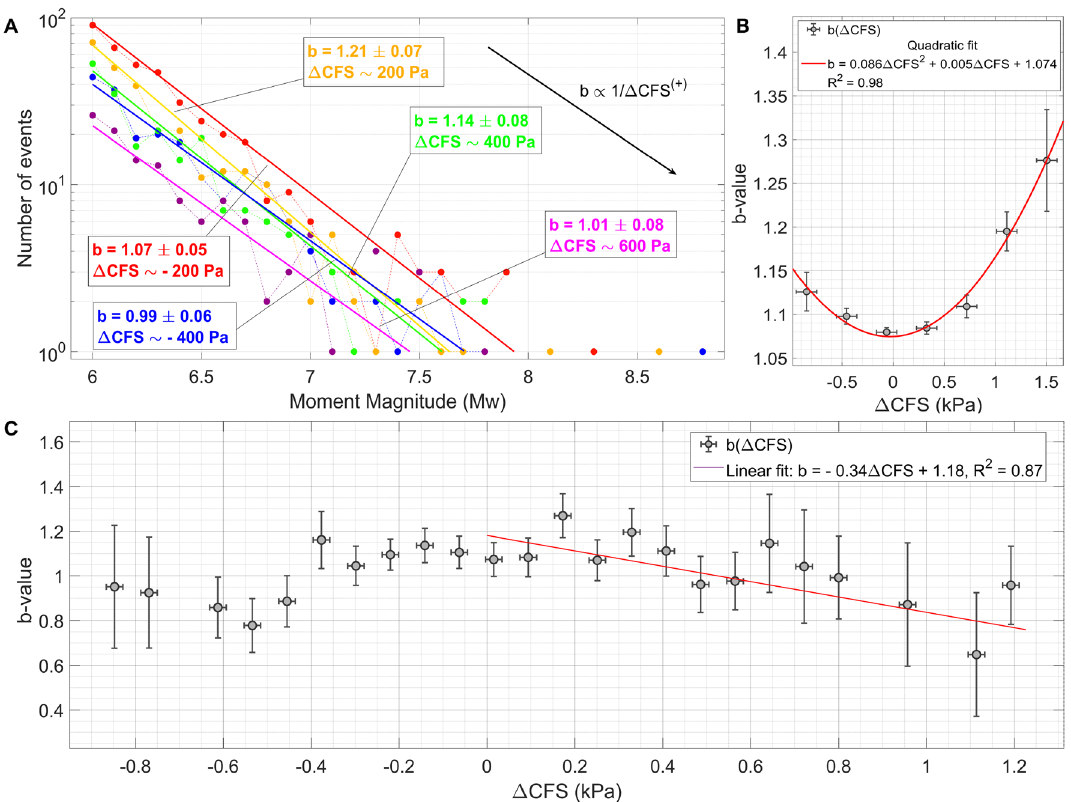
Figure 6. ( A,C ) b is inversely correlated to the intensity of the tidal Coulomb failure stress for large magnitude seismic events. The plot is realized by analysing worldwide seismic events in USGS catalog between 2001 2 and 2021, M w ≥ 6.0 (M wc ≈ 5). ( B ) b ( (cid:31) CFS) is well fitted (R = 0.98) by a parabolic function if only shallow worldwide M w ≥ 4.6 seismic events are included. The plot is realized by analysing seismic events in USGS catalog between 2001 and 2021, depth ≤ 50 km. If compared to the scatter-plot in the lower part of this figure, the difference of the trends strongly suggests that low magnitude shallow earthquakes are more sensitive to tidal stress with respect to larger ones. This conclusion is consistent with Fig.